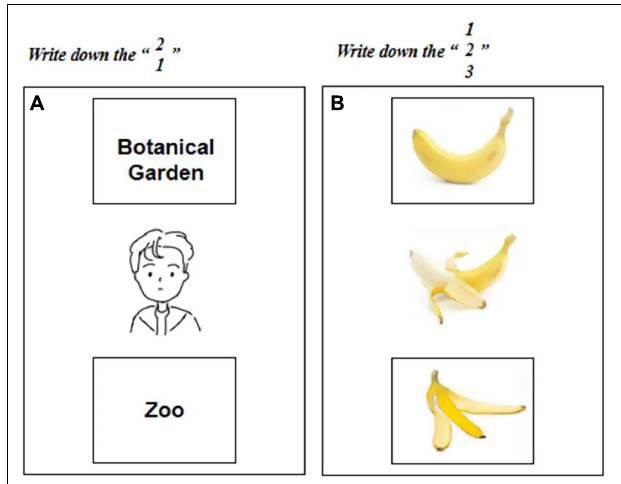
FIGURE 2 | Order diagram of event occurrence (A,B) .There is a character in the middle of the first board with empty squares above and below the character (A) . The mid-term picture of the occurrence of the event is presented in the middle of the second board with two empty squares above and below the mid-term picture (B) .